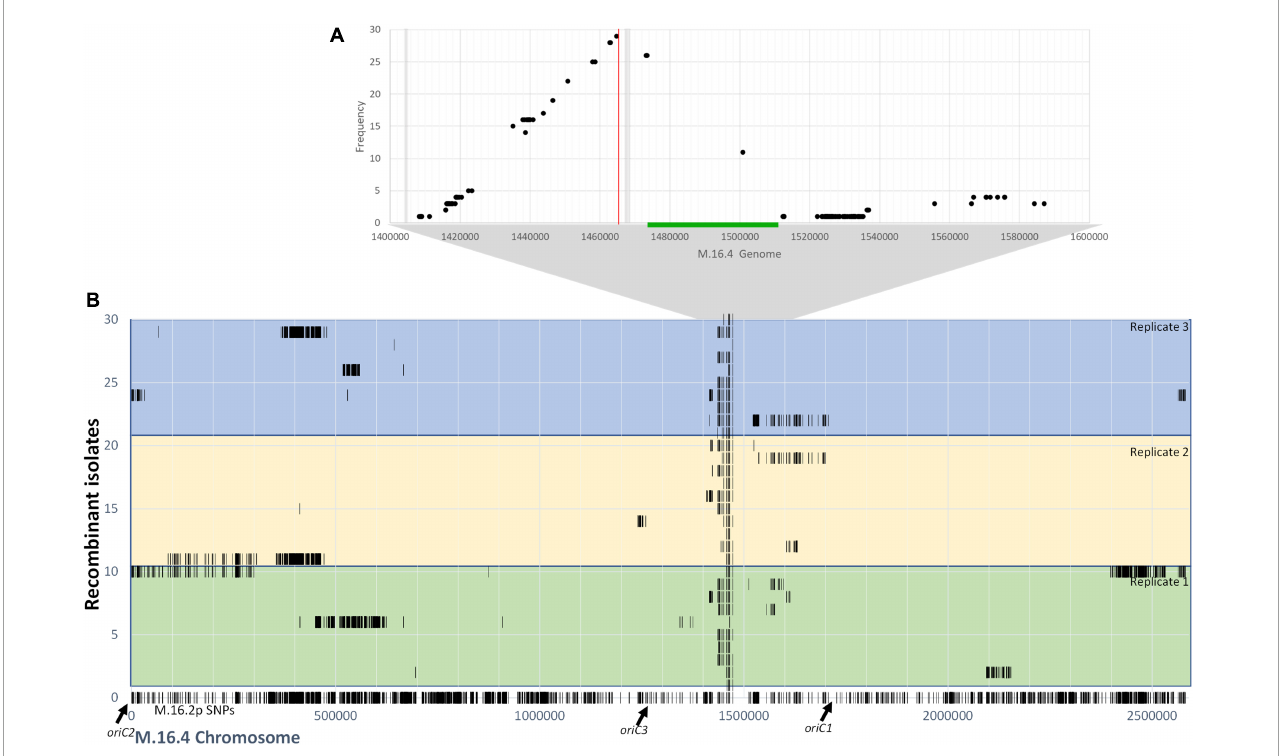
FIGURE6 (A) Frequency of M.16.2p donor SNPs within the argD /pM164 region in RJW004 recombinants. The green bar represents pM164 and the red line represents the argD locus. Gray bar represents variable gene content between strains in M.16.2p. (B) Donor SNP distribution along the M.16.4 chromosome in RJW004 recombinants. The bottom (line 0) represents the SNP positions of M.16.2p (donor) mapped on to M.16.4 genome. The colored blocks represent each replicate, each containing 10 independent